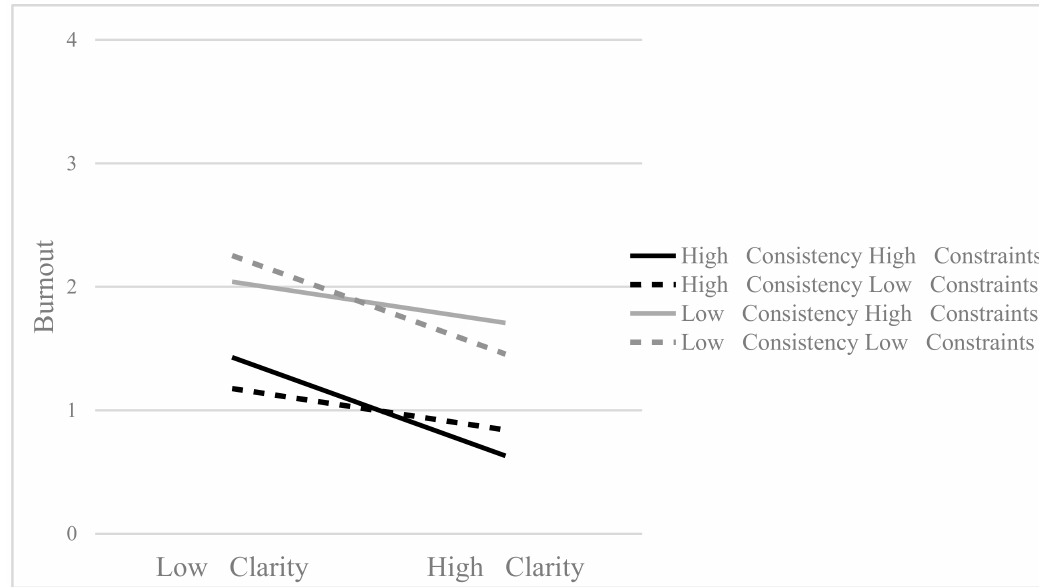
Figure 4. Triple interaction effect to explain burnout in the salespeople sample ( β = − 0.08, p <